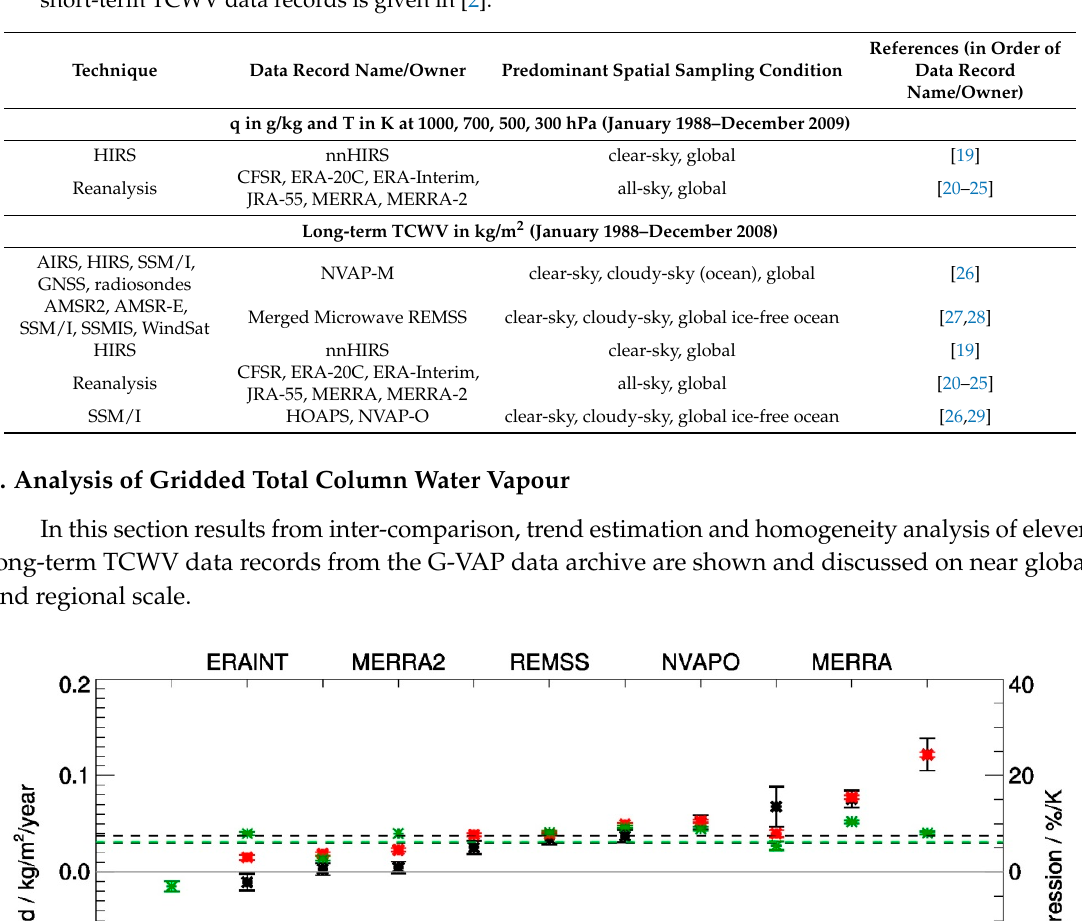
Table 1. Overview of data records in the G-VAP data archive. All data records are available on a common regular longitude/latitude grid of 2 ◦ × 2 ◦ . The archive is freely available via http://dx.doi. org/10.5676/EUM_SAF_CM/GVAP/V001 or at http://gewex-vap.org/?page_id=969. Information on short-term TCWV data records is given in [2].